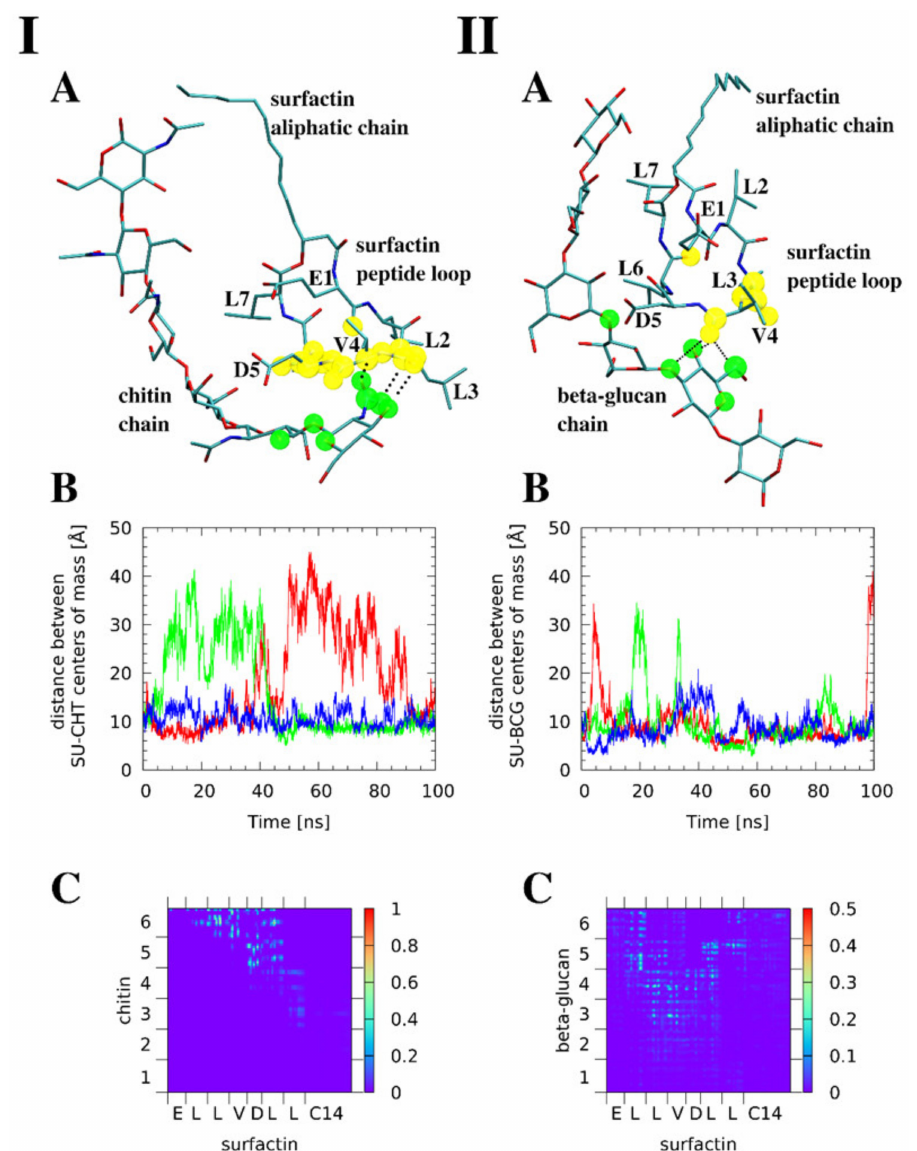
Figure 7. Molecular dynamic studies show that surfactin (SU) is able to form intermolecular complexes with chitin ( I ) and β -glucan ( II ). ( A ) Exemplary snapshots of the molecular dynamics runs; the atoms forming most stable close intermolecular contacts ( < 4 Å) are indicated by transparent spheres (green for the saccharide, yellow for SU). Color coding for atoms: cyan—carbon, blue—nitrogen, red—oxygen, while hydrogen atoms are not shown for clarity. Hydrogen bonds present in the snapshots are indicated by dotted lines. ( B ) Time evolution of distance between centers of mass of SU and the saccharide in three separate simulation runs. ( C ) Map of interatomic contacts between SU and the saccharide—the pixel color indicates the fraction of simulation time during which a particular interatomic contact